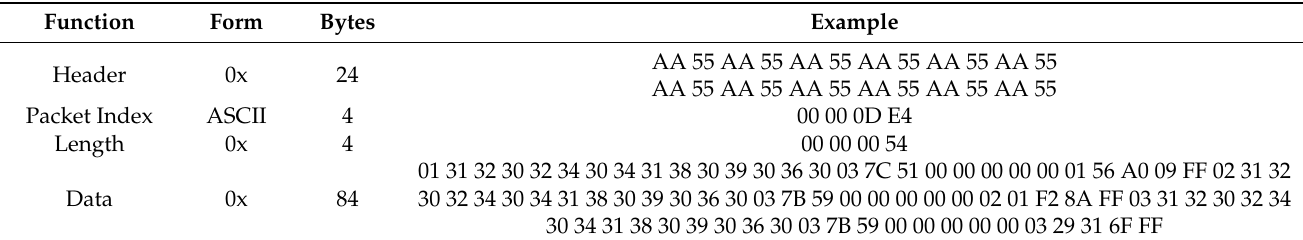
Table 3. Data packet format transmitted between the PS side and the data